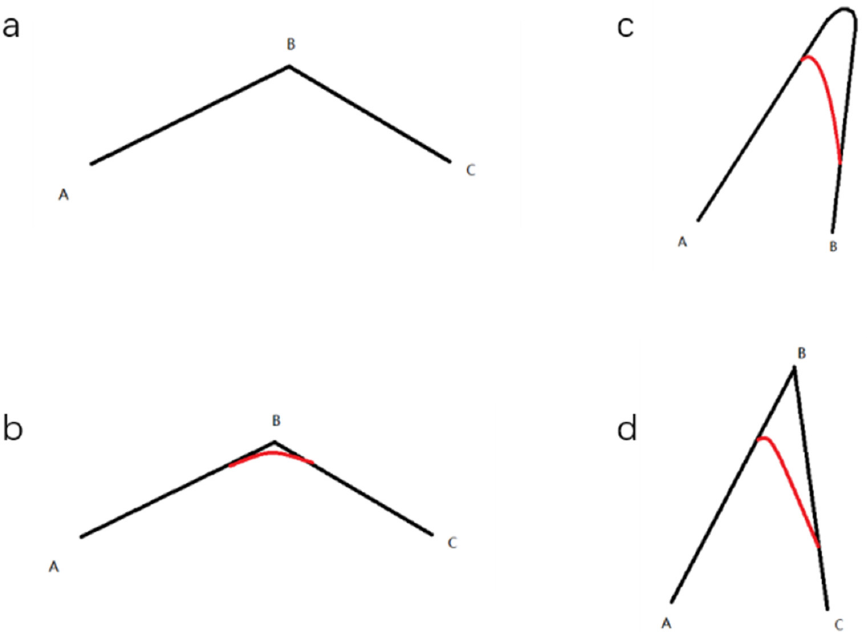
Figure 5. ( a ) Schematic diagram of CFRF printing corner trajectory. ( b ) The corner is obtuse, and the length of BC is long. ( c ) An example of the error generated in the case of small arcs. ( d ) The error generated in the case of acute angles.